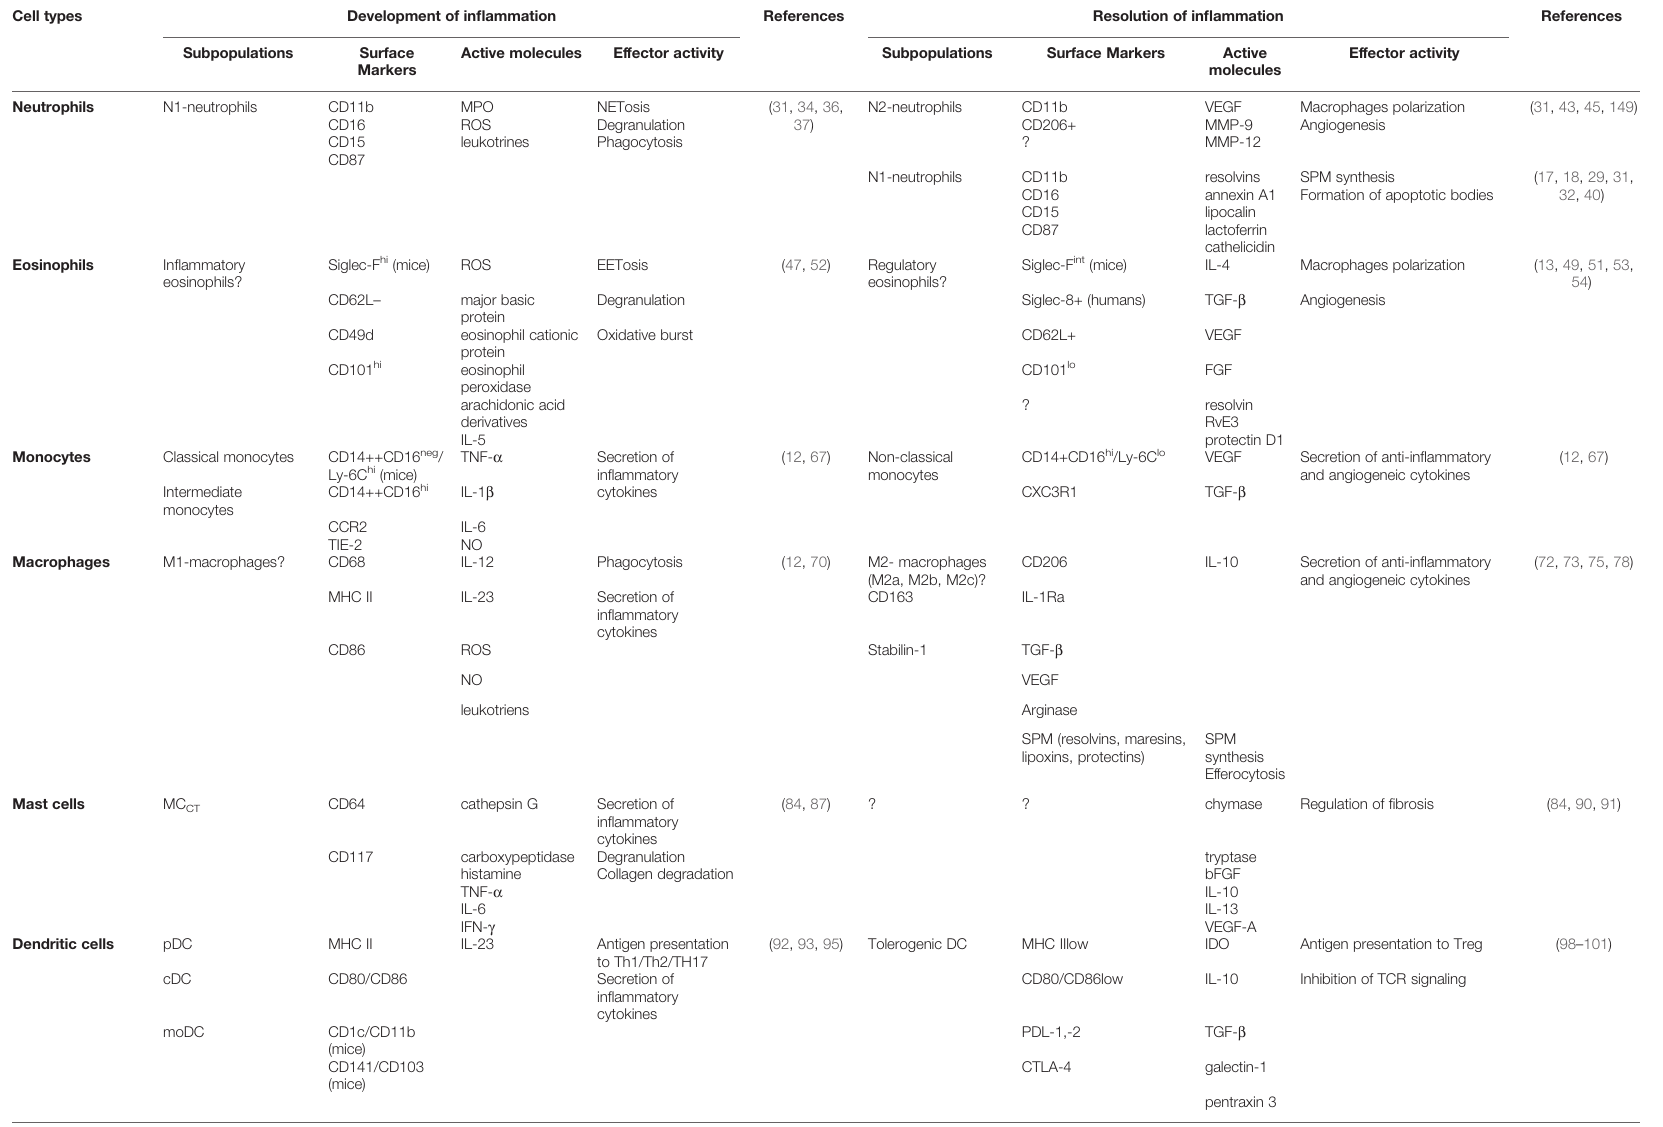
TABLE 1 | Summary characteristics of immune cells involved in development and resolution of in fl ammation in acute myocardial infarction. Cell